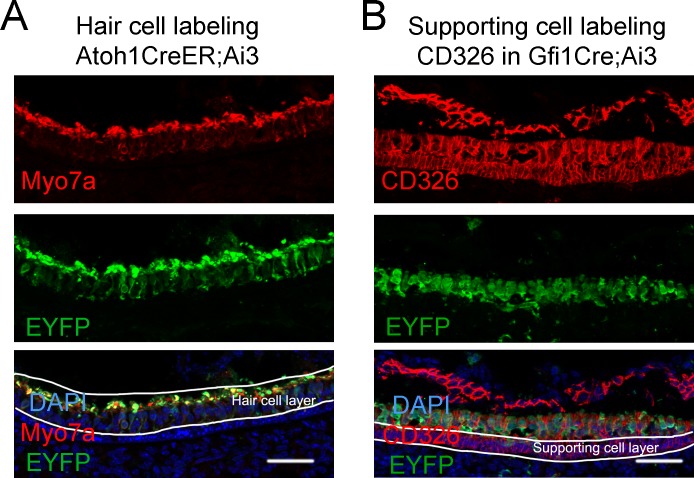
Fluorescence labeling of endogenous epithelial cells for RNA-seq and ATAC-seq.(A) Immunofluorescence staining of utricle sections from 4 to 5 week old Atoh1-CreER; Ai3 mice treated with tamoxifen to show hair cells (Myo7a) and the GFP Cre reporter. (B) Immunofluorescence staining of utricle sections from 4 to 5 week old Gfi1-Cre; Ai3 mice to show CD326 labeling of epithelial cells, and the GFP reporter labeling hair cells. Scale bars 50 µm.